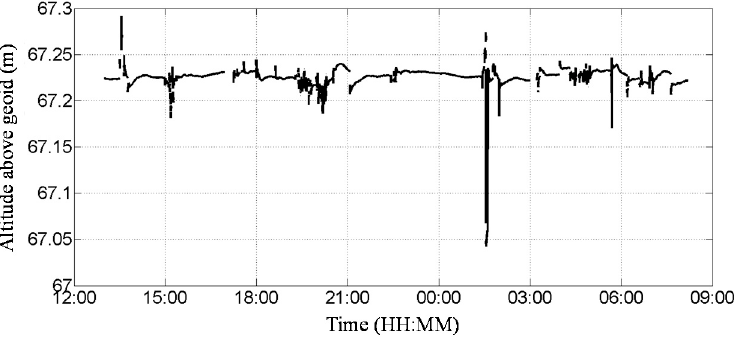
Figure 2. Altitude of the GNSS receiver above the geoid in the static test.